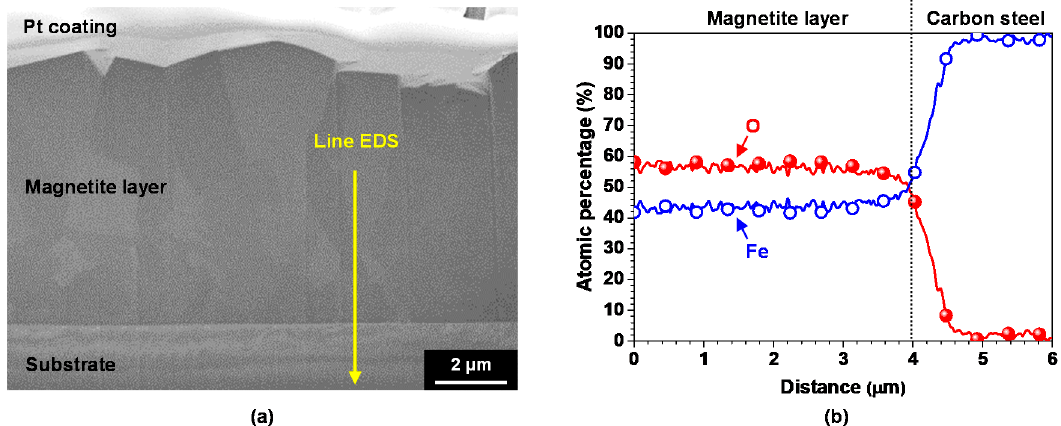
Figure 4. ( a ) Cross-sectional SEM image and ( b ) EDS line profile of the electrodeposited magnetite layer.